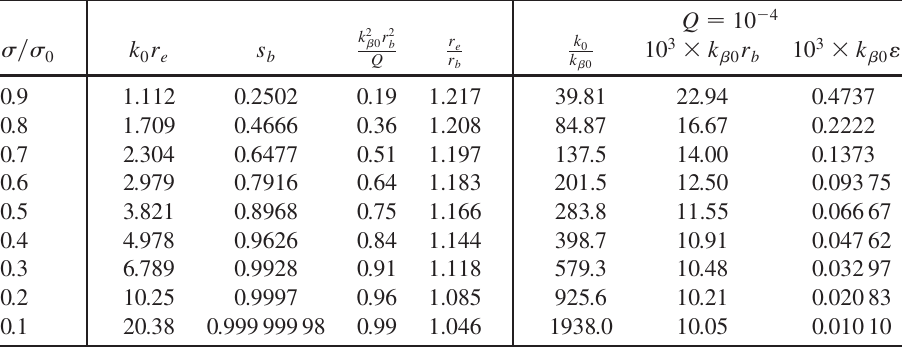
TABLE III. Dimensionless waterbag equilibrium parameters in Fig. 12 calculated for specified (cid:3)=(cid:3) . The values of k 0 independent of Q